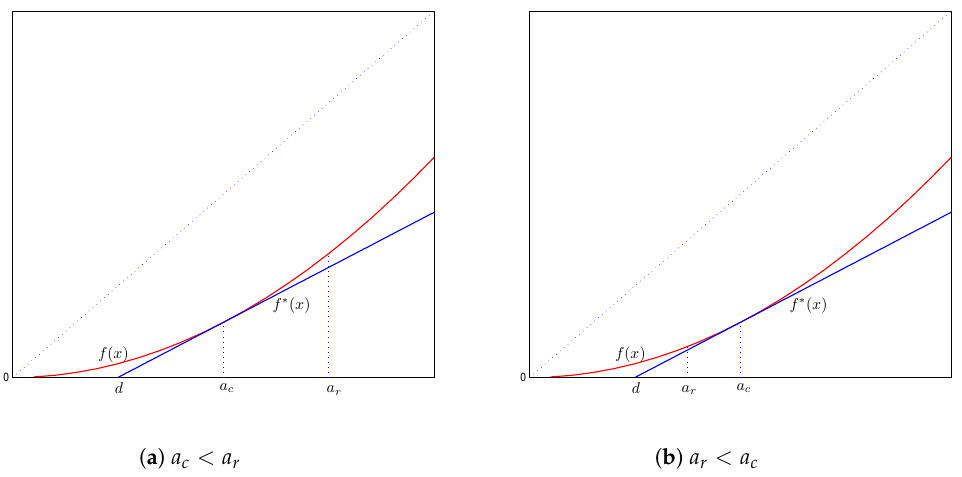
Figure 1. Optimal ceded functions in C 1 : Case